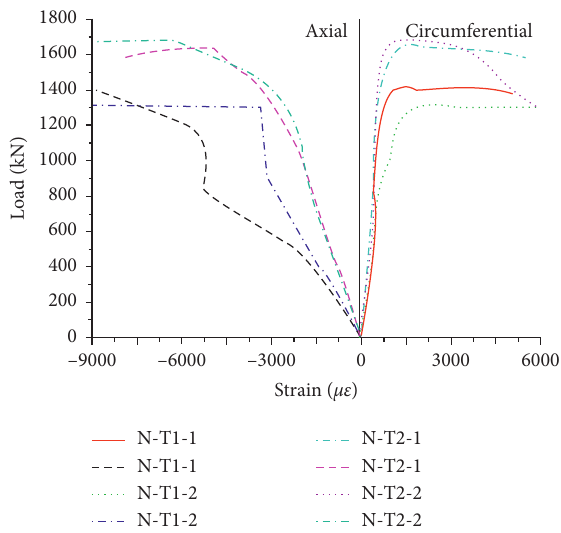
Figure 7: Load-strain